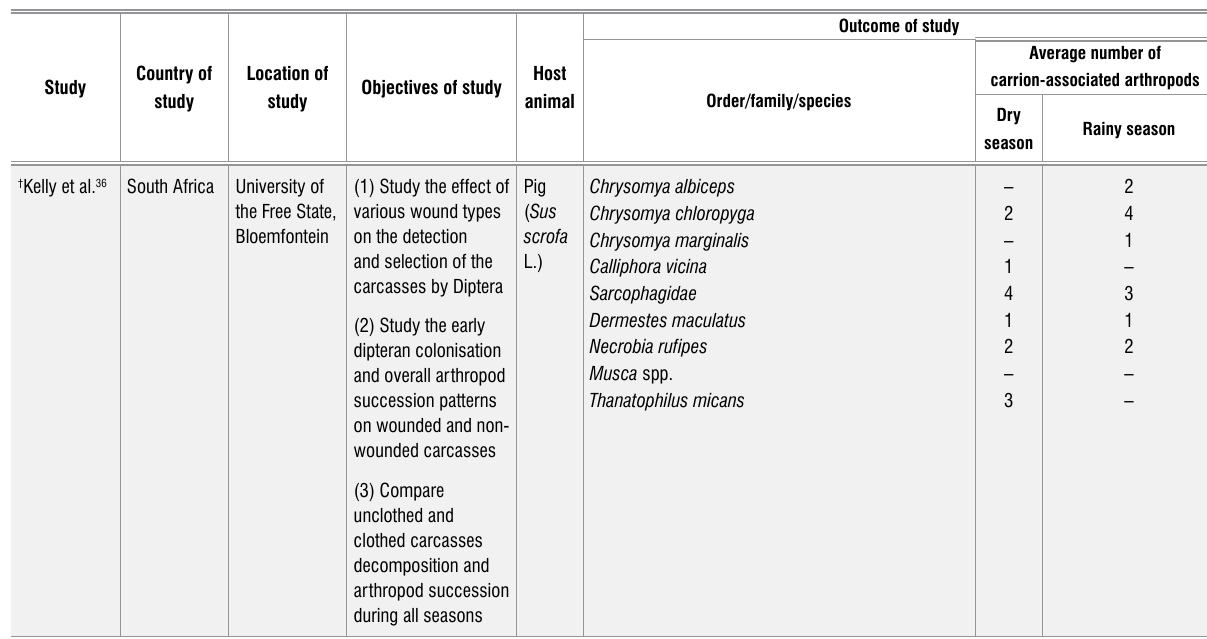
Table 3: Summary of the diurnal and nocturnal oviposition by forensically important arthropods on pork chops, chicken liver and rat carcasses in southern Africa